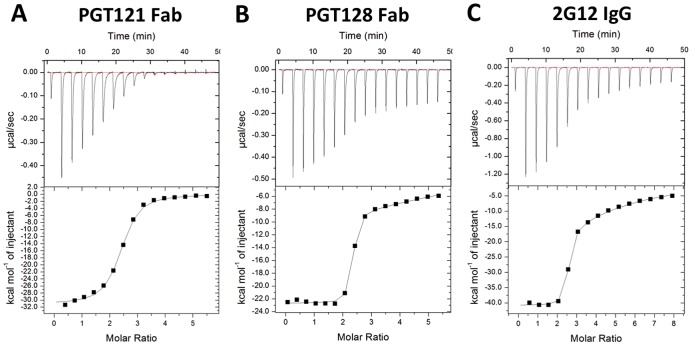
BG505 SOSIP.664 gp140 trimer antigenicity by ITC.The top panels show the raw data and the bottom panel the binding isotherms for representative ITC binding experiments measuring the binding of BG505 SOSIP.664 gp140 trimers to: (A) PGT121 Fab, (B) PGT128 Fab, (C) 2G12 IgG (domain-exchanged). The thermodynamic parameters of binding are listed in Table 1.